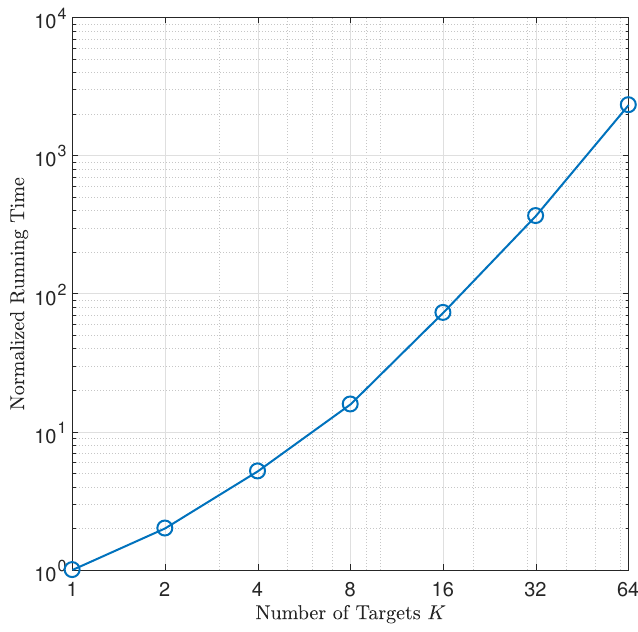
Figure 7. Normalized running time for locating multiple disjoint